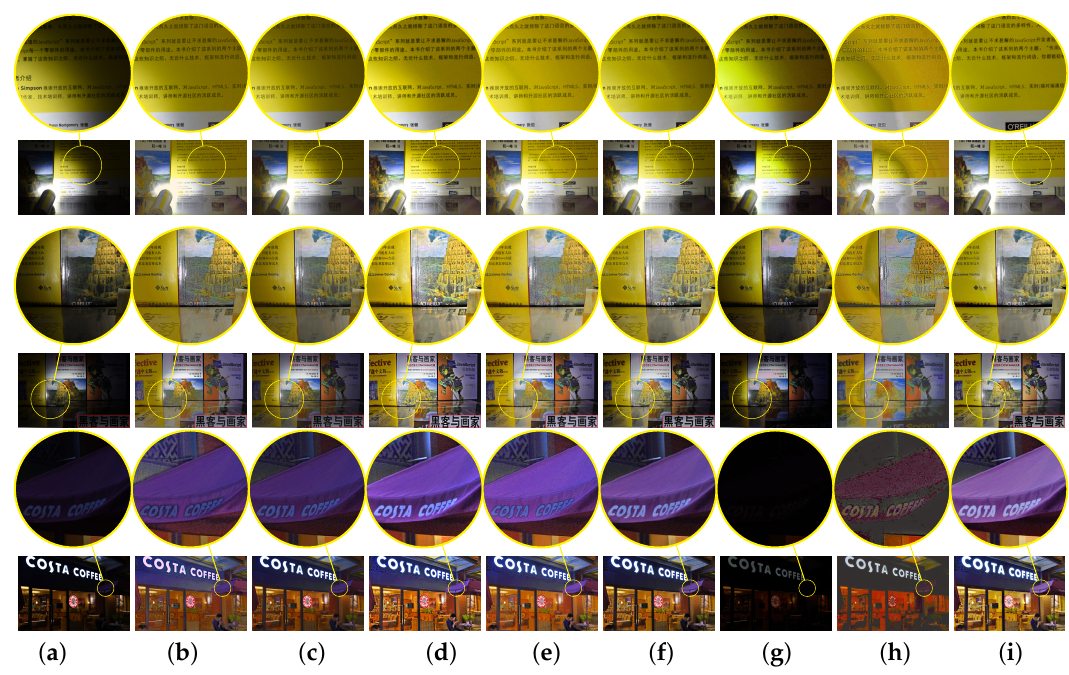
Figure 7. The enhanced results (the images of first and second rows of images are technical books about Java) of eight algorithms. ( a ) shows the input images, ( b ) shows results by using NPE [7], ( c ) shows results by using SNIE [13], ( d ) shows results by using LIME [10], ( e ) shows results by using Dong [8], ( f ) shows results by using LECARM [15], ( g ) is by using [18], ( h ) is by using [19], and ( i ) is by using our